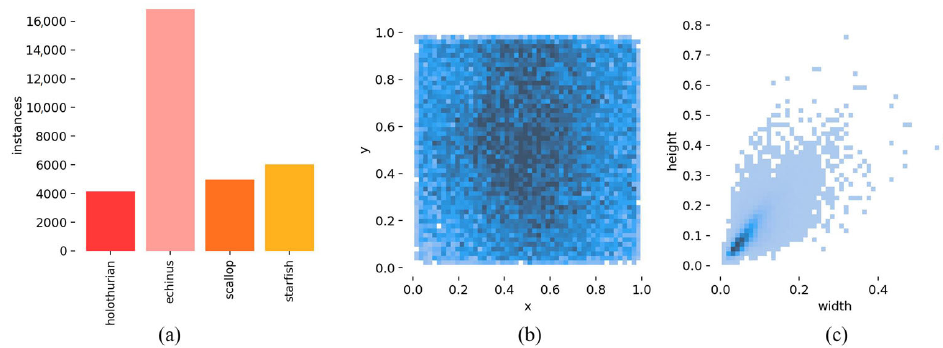
Figure 6. Statistical results of the URPC dataset: ( a ) bar chart of the number of targets in each class; ( b ) normalized target location map; ( c ) normalized target size map. Table 2. Anchor box parameters of the URPC